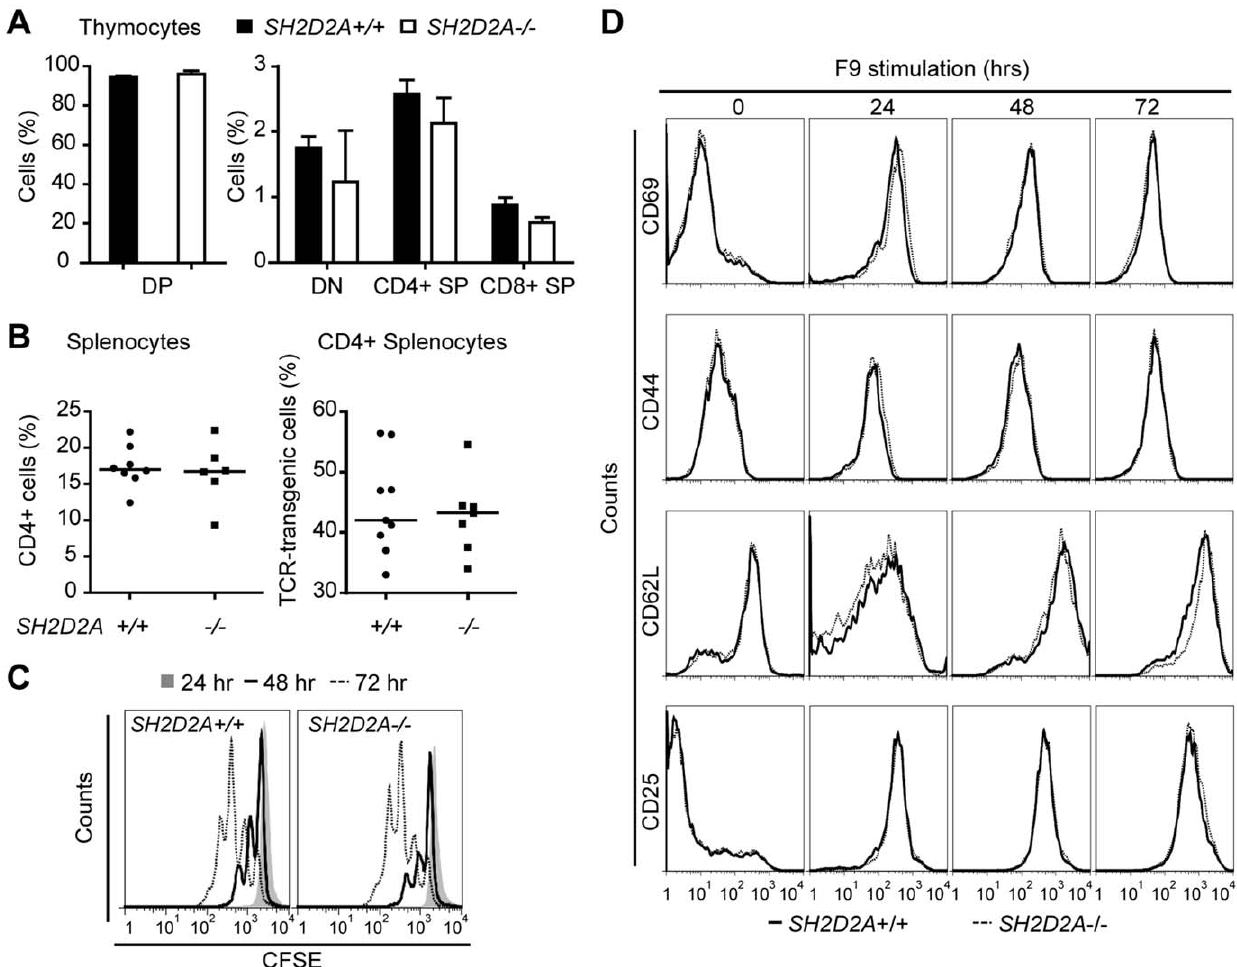
Figure 4. Characterization of SH2D2A -deficient Id-specific TCR-transgenic CD4 + T cells. (A) Thymocytes from Id-specific TCR-transgenic mice with indicated genotypes (9–15 weeks old) were labeled with anti-transgenic TCR (GB113), anti-CD4 and -CD8 mAbs. Expression of CD4 and CD8 on GB113 + thymocytes was monitored by flow cytometry. The mean average percentage with SD of double positive (DP), double negative (DN), single positive (SP) GB113 + CD4 + and CD8 + thymocytes is indicated for each genotype (n=3). (B) Splenocytes from normal ( SH2D2A + / + ) and age- matched SH2D2A- deficient ( SH2D2A 2 / 2 ) mice (6–14 weeks old) were labeled with anti-CD4 and GB113 and expression was monitored by flow cytometry. Diagrams show the frequency of CD4 + T cells (left diagram) and the percentage of CD4 + T cells that express the Id-specific transgenic TCR (GB113 + ) (right diagram). The median values are shown as lines in the diagrams. (C) CFSE labeled CD4 + T cells from TCR transgenic SH2D2A + / + (upper diagram) and SH2D2A 2 / 2 (lower diagram) were harvested after 24, 48 and 72 hours in culture with Id-positive F9, labeled with GB113 antibody. The CFSE dilution in GB113 + CD4 + T cells was measured by flow cytometry; grey area - CFSE profiles after 24 hours, open area (black line) - CFSE profiles after 48 hours and open area (stippled line) - CFSE profiles after 72 hours. One representative experiment out of four is shown. (D) Unlabeled CD4 + T cells from SH2D2A + / + and SH2D2A 2 / 2 mice were cultivated as in C. Prior to and after 24, 48 and 72 hours, cells were stained with GB113 in addition to CD69, CD44, CD62L or CD25 mAbs to assess T cell activation by flow cytometry. FACS plots gated on GB113 + CD4 + T cells from one representative experiment of at least three are shown.